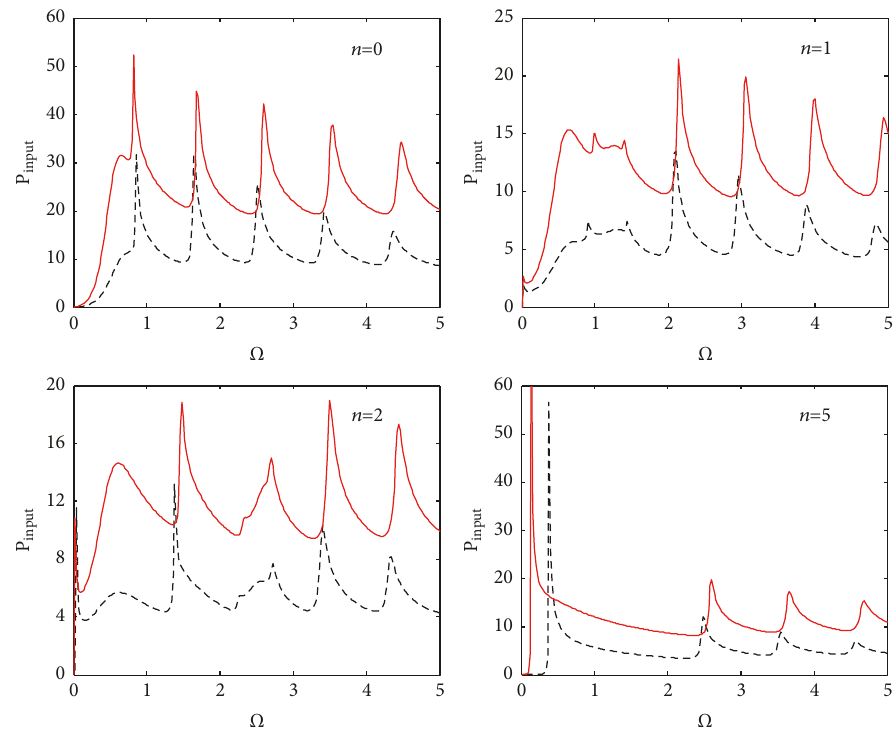
Figure 11: The comparison of nondimensional input power flow into the shell with ℎ/𝑅 = 0.004 ; black dashed line: ℎ/𝑅 = 0.075 ; red solid line: ℎ/𝑅 = 0.0375